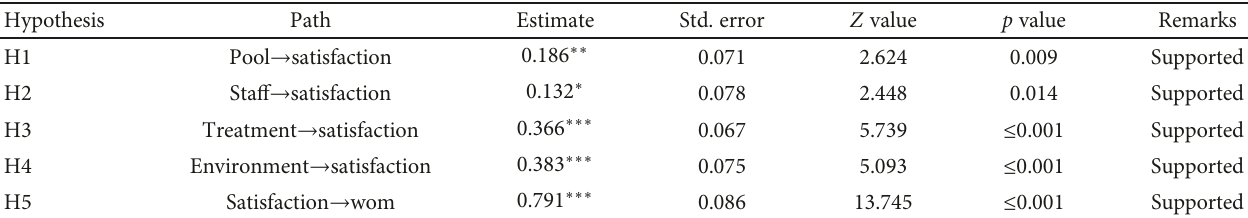
Table 5: Results of path analysis.